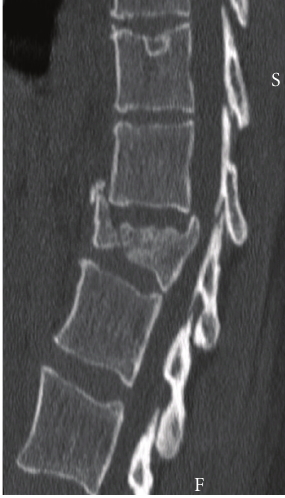
Figure 2: CT Scan confirming the burst fracture of T12.